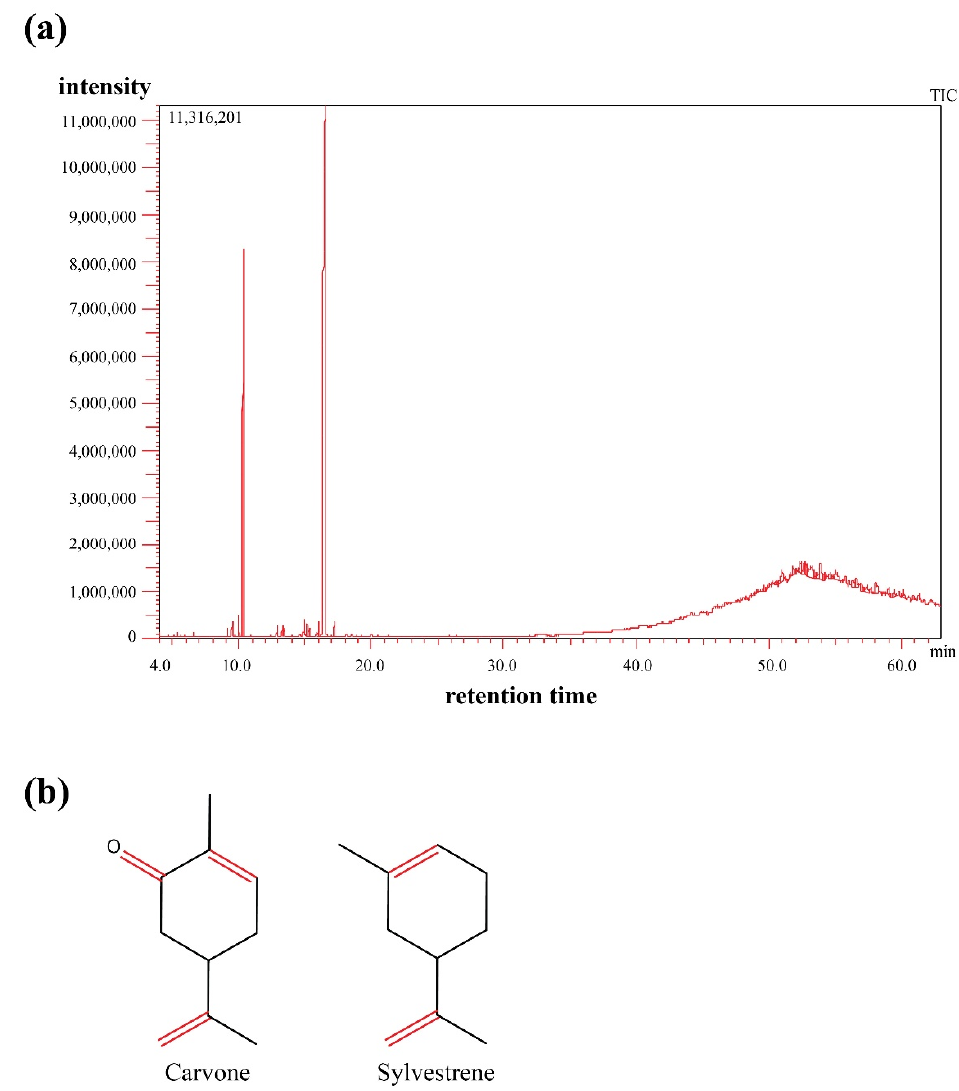
Figure 1. GC-MS profile of caraway fruits essential oil in ( a ) and major components (carvone and sylvestrene) in ( b ). Table 1. Essential oil composition of C. carvi fruits using GC-MS analysis.